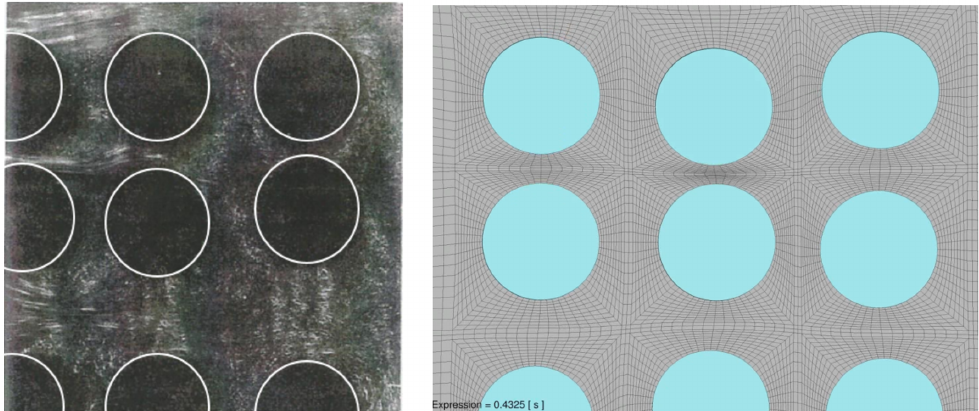
Figure 18. ( Left ): experimental deformation at 0.44 m/s. ( Right ): numerical deformations for the same velocity